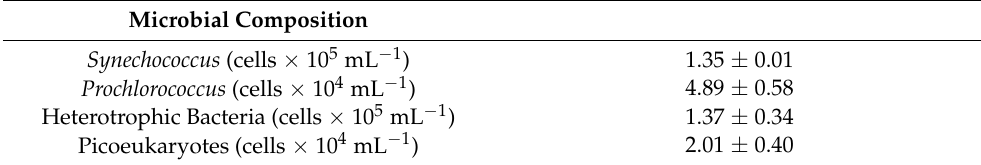
Table 2. Flow cytometric counts of the initial microbial community. Microbial